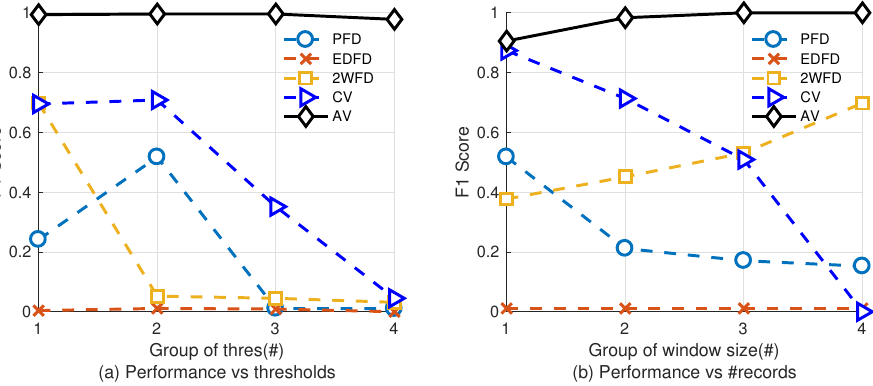
Figure 5. Performance of Evaluation model vs. parameters. Table 5. Thresholds used by experiment on parameters.